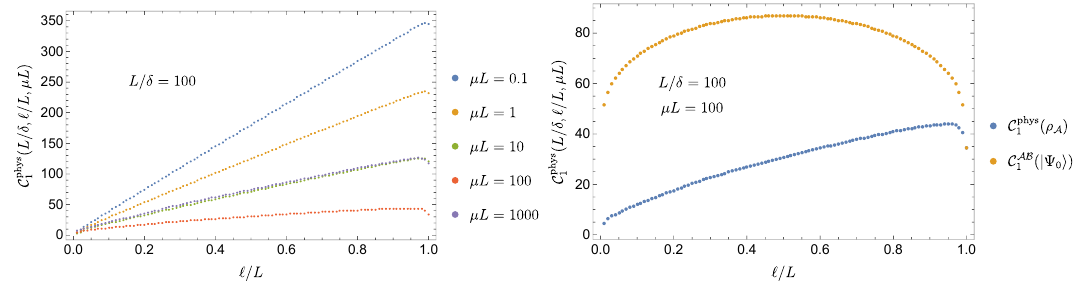
Figure 19 . Left panel: subregion complexity as a function of the subregion size in physical basis for reference frequencies (cid:22)L = 0 : 1, 1, 10, 100, 1000. Right panel: comparison of the subregion complexity to the complexity of the ground state in the physical basis for (cid:22)L = 100. In both plots, the cuto(cid:11) was set to L=(cid:14) = N = 100 and the mass to mL = 0 :